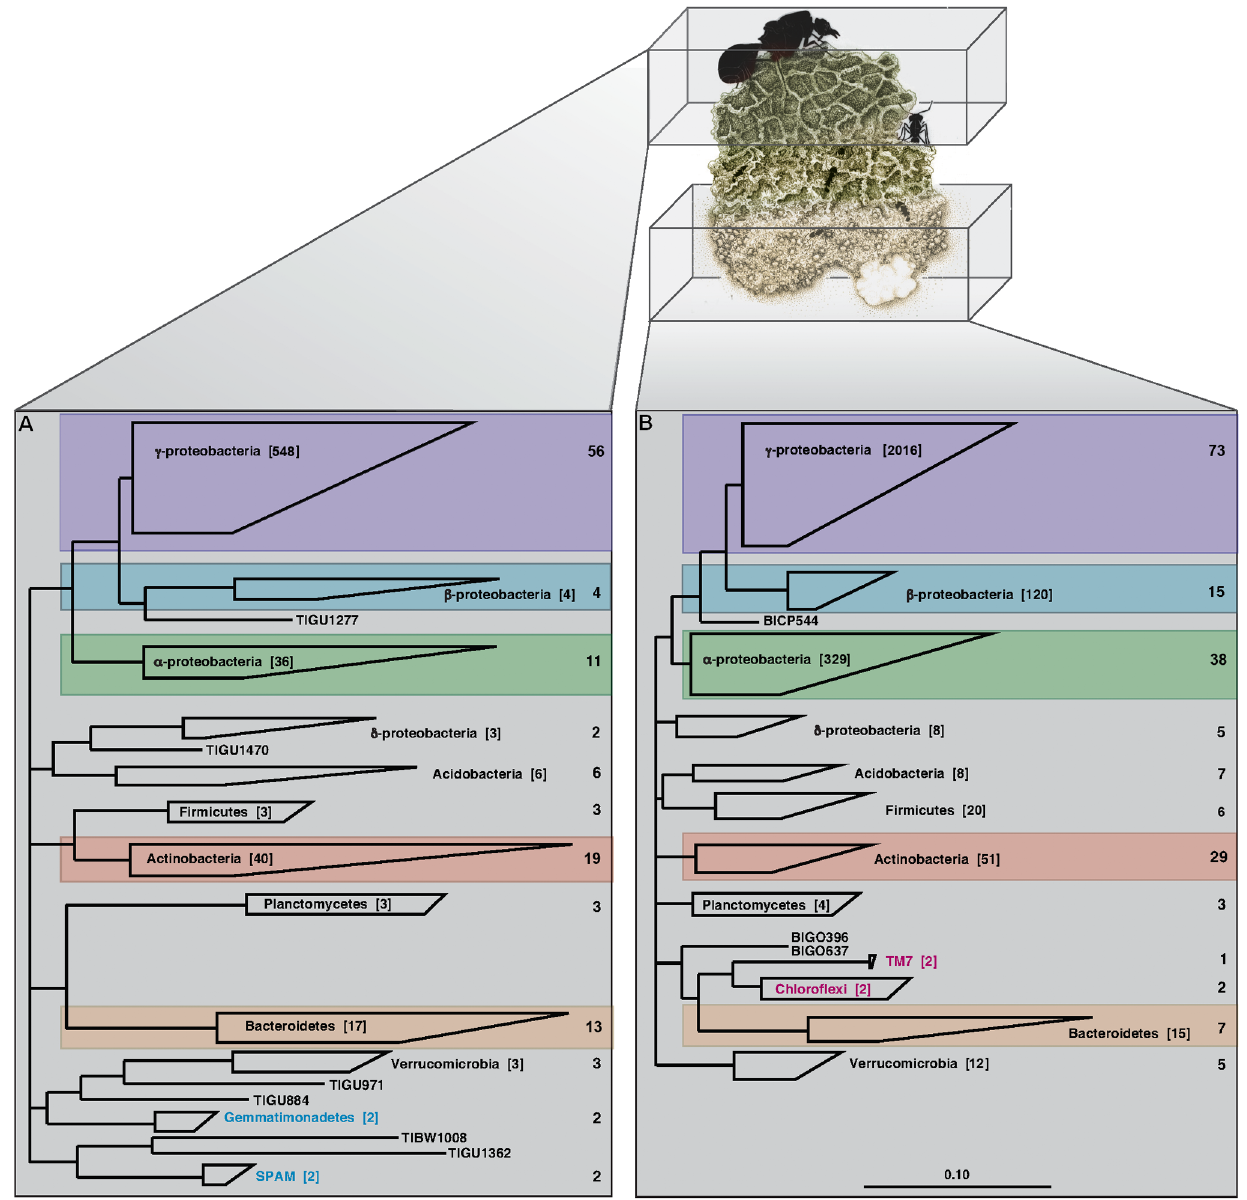
Figure 2. Phylogenetic analysis of the leaf-cutter ant fungus garden. A phylogenetic analysis of near-full length 16S rDNA sequence libraries from the top (A) and bottom (B) layers of leaf-cutter ant fungus gardens was performed. Identified phylotypes were tabulated and mapped to their respective phyla as shown. Total numbers of phylotypes are shown to the right of each phylum, and the total number of clones for each phylum is shown in square brackets. Comparison of top and bottom layers indicates that leaf-cutter ant fungus gardens are dominated by phylotypes belonging to the a -proteobacteria, b -proteobacteria, c -proteobacteria, Actinobacteria, and the Bacteroidetes as highlighted. Phylotypes belonging to specific phyla were found exclusive to top and bottom samples, including the Gemmatimonadetes and candidate phylum SPAM (blue lettering) in the top, and the Chloroflexi and candidate phylum TM7 (red lettering) in the bottom of the garden. doi:10.1371/journal.pgen.1001129.g002 PLoS Genetics |